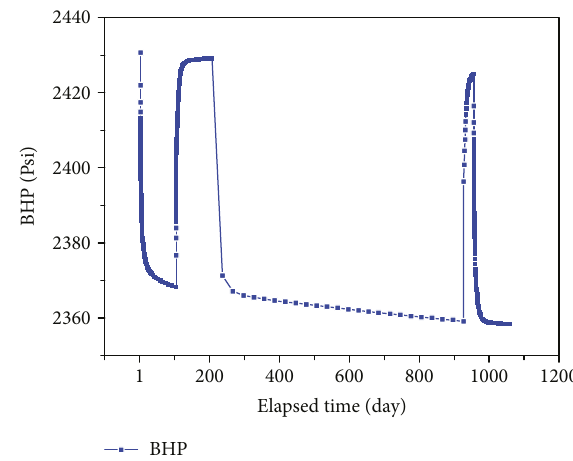
Figure 19: The log-log plot of the pressure response in gas-water reservoir under constant pressure boundary. The pressure derivative of DD and BU goes up when the pressure reached transition zone and then goes down when the pressure reached outer boundary.